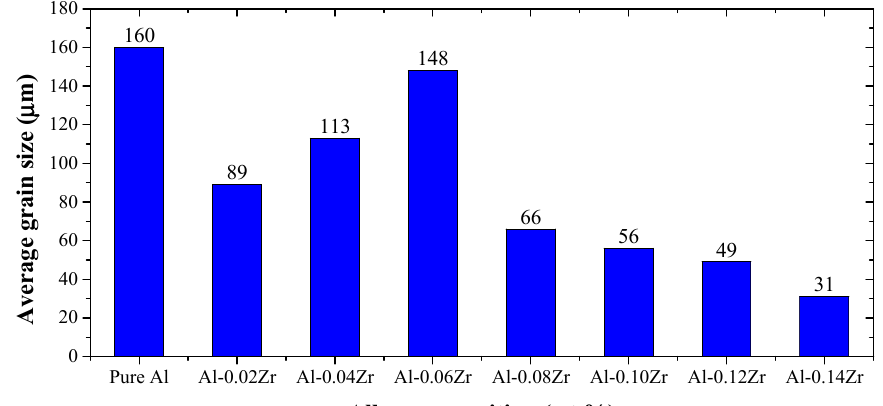
Alloy composition (wt.%) Figure 4. Average grain size (µm) vs. Zr concentration plot. Figure 4. Average grain size ( µ m) vs. Zr concentration plot.